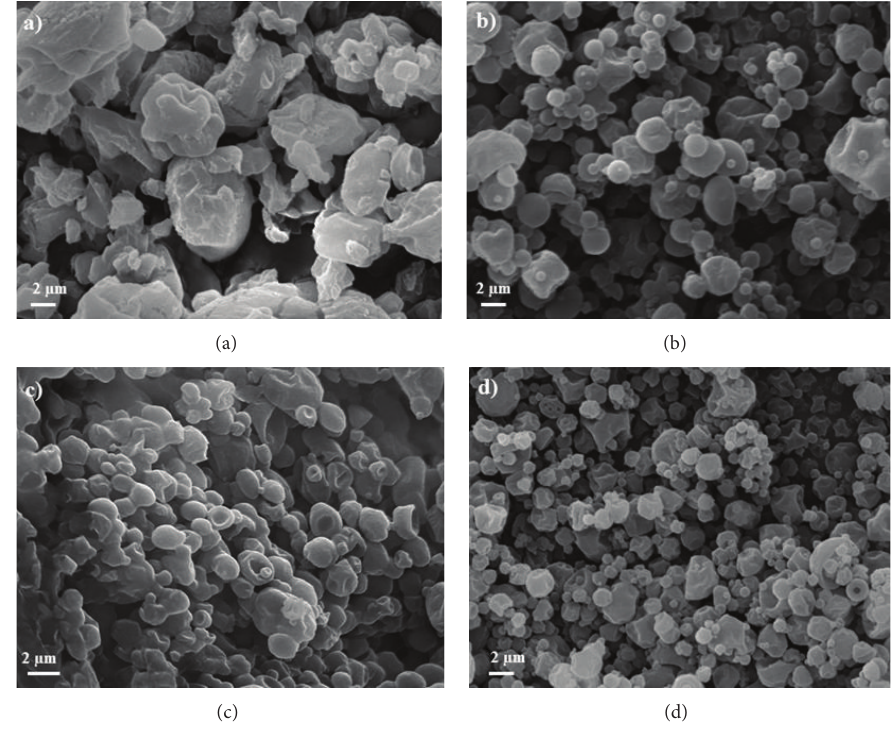
Figure 1: SEM pictures of powders obtained from (a) #2 (110 ∘ C, 3% w/v, 7 𝜇 m nozzle), (b) #1 (110 ∘ C, 5% w/v, 7 𝜇 m nozzle), (c) #4 (110 ∘ C,